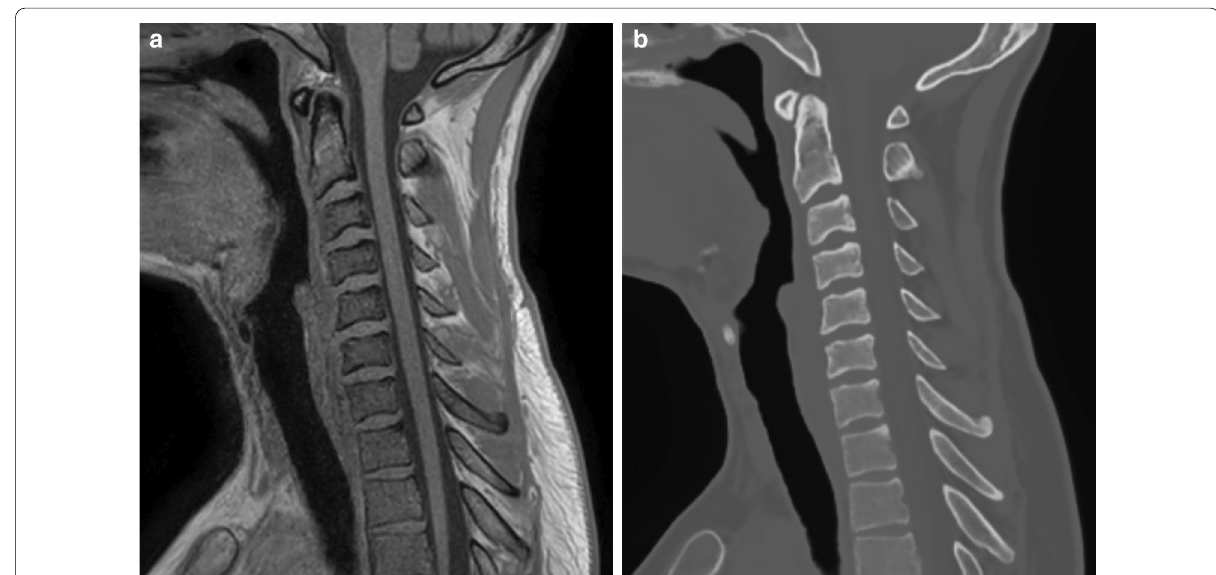
Fig. 4 The CE-marked BoneMRI software product [16] (BoneMRI V1.1, MRIguidance BV, Utrecht, The Netherlands) has been provided as a self-contained application connected to the local PACS through the IMAGR platform. The figure shows T1-weighted MRI (left) and reconstructed BoneMRI (right) images of the cervical spine of a healthy volunteer. The 3D BoneMRI image is reconstructed from the T1wMRI images using the BoneMRI software and pushed back into PACS